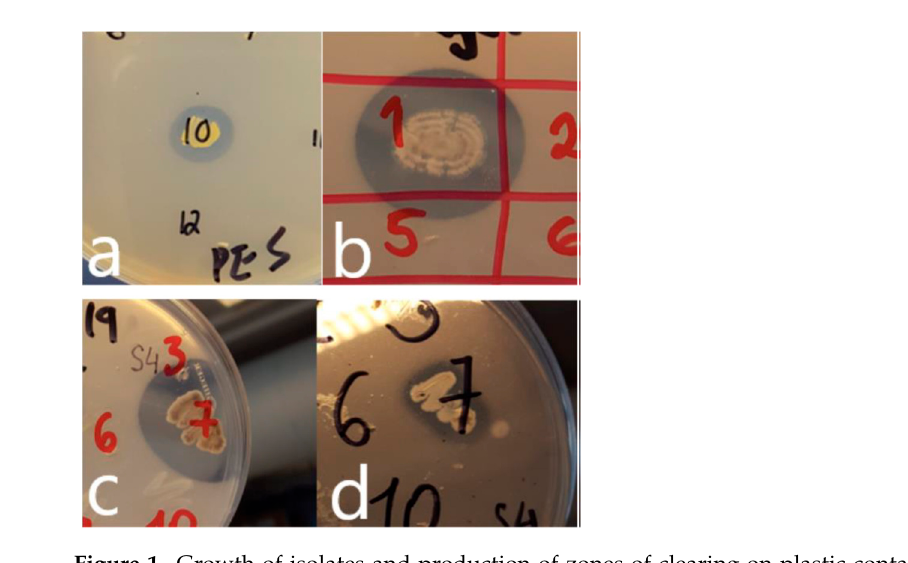
Figure 1. Growth of isolates and production of zones of clearing on plastic-containing agars ( a ) Rhodococcus sp. (isolate vii; Table 2) on PES-agar ( b ) Streptomyces sp. (isolate iv; Table 2) on PHB-agar ( c ) Streptomyces sp. (isolate viii; Table 2) on PHB-agar (d) Streptomyces sp. (isolate viii; Table 2) on PCL-agar. Table 2. Polymer degrading profiles for environmental isolates. 11 isolates based on similarity searches of partial 16S rDNA gene sequences. Table 3. Identification of isolates based on partial sequencing of the 16S rDNA gene.